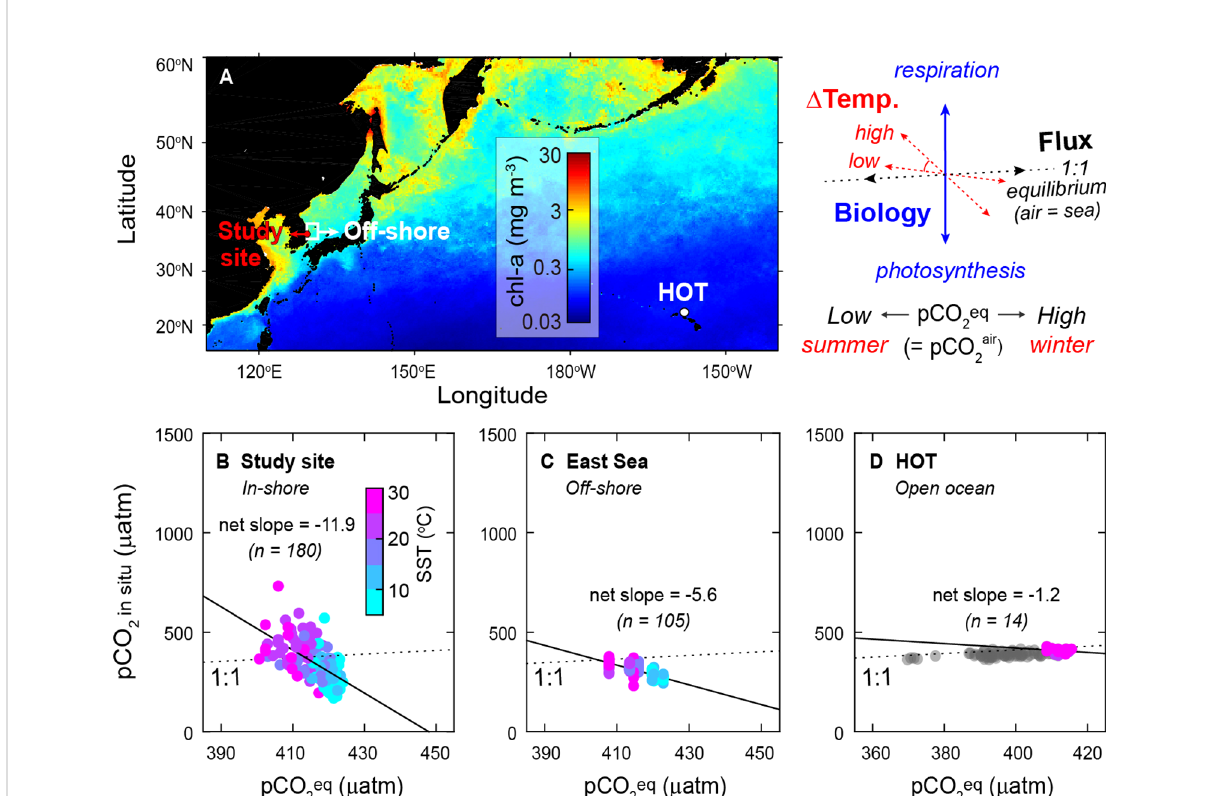
FIGURE 7 (A) Distribution of the annual mean chlorophyll-a concentration of 2019 in the northwestern Paci fi c Ocean, (B – D) correlations between the fully equilibrated pCO 2 with atmospheric CO 2 (pCO 2 eq = pCO air 2 ) and in situ seawater pCO 2 measured in the regions with different seasonal temperature extremes and biological activities: (B) the macroalgal habitat (plotted data were obtained during the discrete measurements during 2019 − 2020; r 2 = 0.403, p = 1.1 ×10 − 21 ), (C) the East Sea: the off-shore of coastal Korea (in February, April, August, and October for 2019 − 2020; r 2 = 0.494, p = 6.6 ×10 − 17 ), and (D) Station ALOHA of the Hawaii Ocean Time-series measurements (2019 − 2020; r 2 = 0.035, p = 0.52; gray symbols for 2000 − 2019). The colored symbols indicate the sea surface temperature. The diagram displays the factors determining the correlations between pCO 2 eq and pCO 2 in situ (the x-axis and y-axis of B – D , respectively): the seasonal temperature extremes and the air − sea C fl ux regulate an overall slope of the correlation (combined angle of the dotted red and black arrows), and the biological metabolisms affect the magnitude of deviations (length of blue arrow), which affects the net